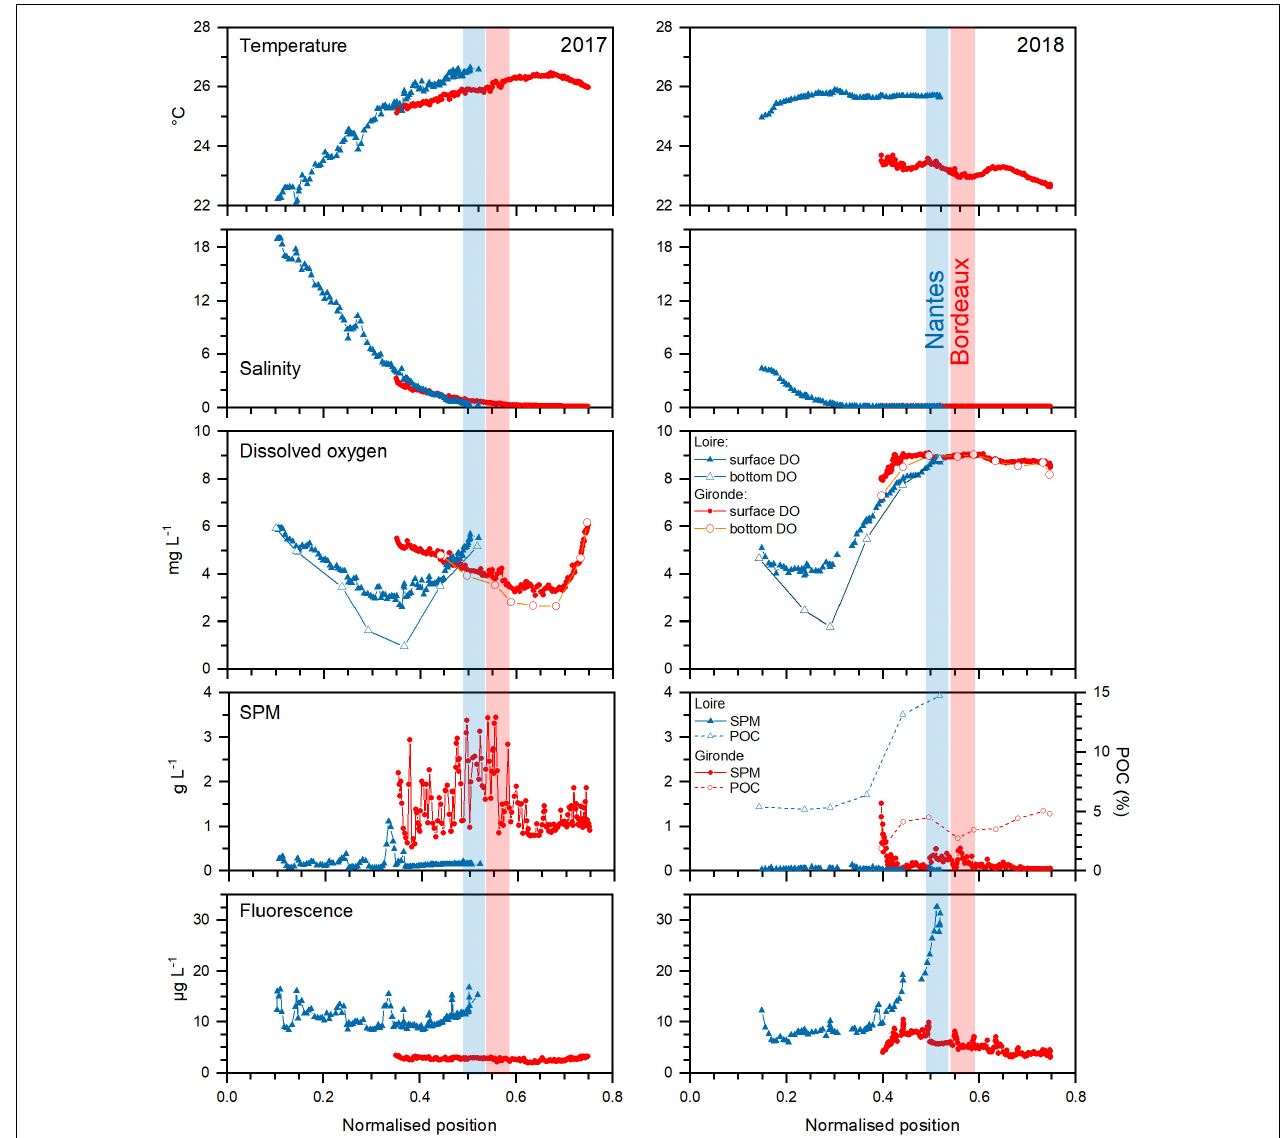
FIGURE 4 | Longitudinal surveys of dissolved oxygen and ancillary data (temperature, salinity, suspended particulate matter, fluorescence) in the Loire and Gironde estuaries in 2017 and 2018. POC content of SPM was determined only in 2018 (9 and 6 samples collected in the Gironde and Loire estuary, respectively). The distance from the mouth is normalized by the total length of the corresponding estuary. The measurement dates were the June 21, 2017 and July 5, 2018 in the Loire estuary; the June 27, 2017 and June 28, 2018 in the Gironde